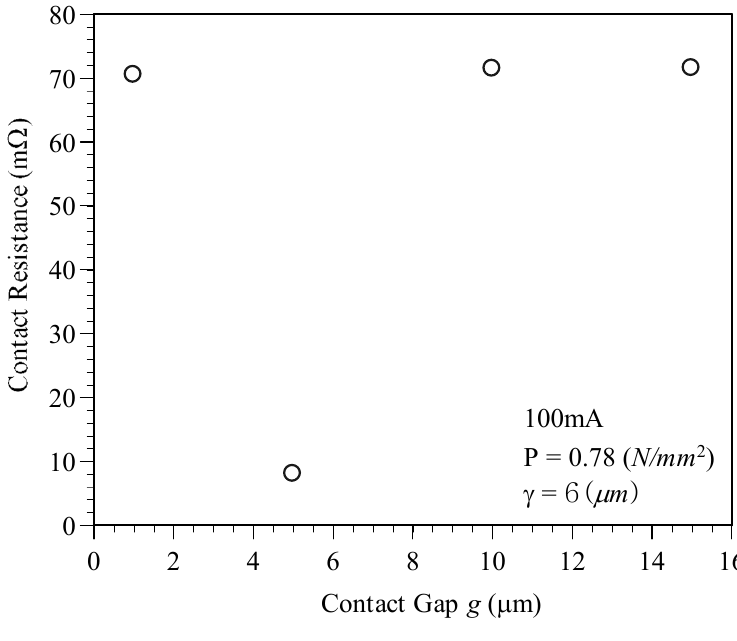
Figure 10. Variation in maximum contact resistance at the microcantilever-electrode contact area for various contact gaps.